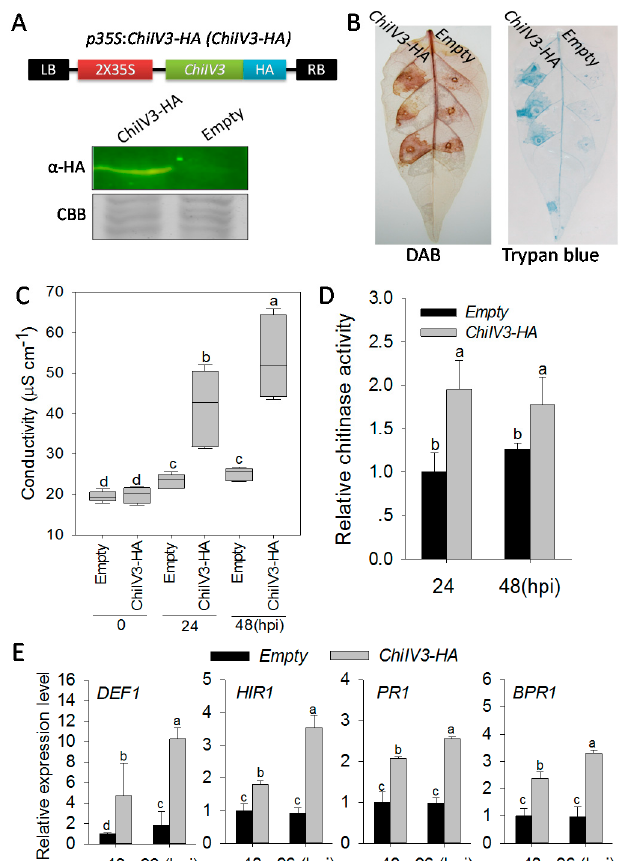
Figure 5. Transient overexpression of ChiIV3 triggered intensive cell death in pepper leaves. ( A ) The schematic diagram of the p35S:ChiIV3-HA vector and the immunoblotting analysis of ChiIV3-HA transiently expressed in pepper leaves. An anti-HA antibody was used to detect ChiIV3-HA fused protein in the immunoblotting analysis. CBB was used to normalize the total protein levels. 2 × 35S, two copies of the cauliflower mosaic virus 35S promoter; LB, left border; RB, right border; CBB, Coomassie Brilliant Blue; α -HA, α -hemagglutinin (HA) antibody; ( B ) The DAB and trypan blue staining of pepper leaves transiently overexpressed ChiIV3-HA ( p35S:ChiIV3-HA ) at 48 hpi (OD 595 = 0.6). The experiment was performed three times independently with similar results obtained each time. DAB, DAB staining; Trypan blue, trypan blue staining; ( C ) Conductivity measurement of discs of pepper leaves infiltrated with GV3101 cells harboring p35S:ChiIV3-HA or p35S:00 (control). Hpi, hours post infiltration; ( D ) The relative chitin content of pepper leaves transiently overexpressed ChiIV3-HA. The chitin content of the control pepper leaves (expressed p35S:00 ) was set to “1”. Hpi, hours post infiltration; ( E ) Quantification of transcript levels of defense-related marker genes in ChiIV3-HA transiently overexpressed pepper leaves at different time-points. DEF1 , a pepper defensing gene in response to pathogen infection; HIR1 , a pepper gene encodes a hypersensitive induced reaction (HIR) protein; PR1 , PATHOGENESISRELATED PROTEIN1 ; BPR1 , the defense-related genes BPR1 (basic PR-1). The transcript levels of the marker genes in the control pepper leaves (transiently expressing p35S:00 at 48 hpi was set to “1”. Hpi, hours post infiltration; ( C – E ) Values are means ± SD ( n = 6). Error bars indicate SD. Different letters indicate significant differences determined by Fisher’s protected LSD test ( p < 0.05).